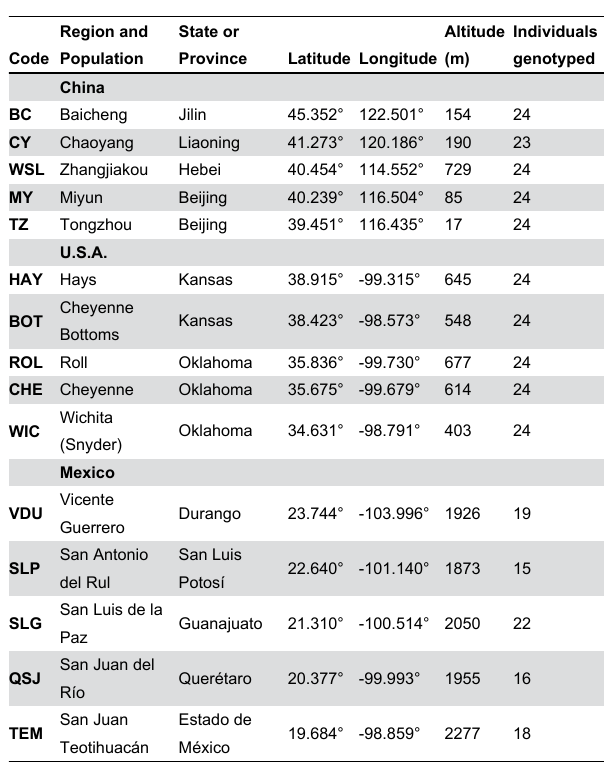
Table 1. Localities and number of individuals successfully genotyped for each of the 15 populations analysed in this